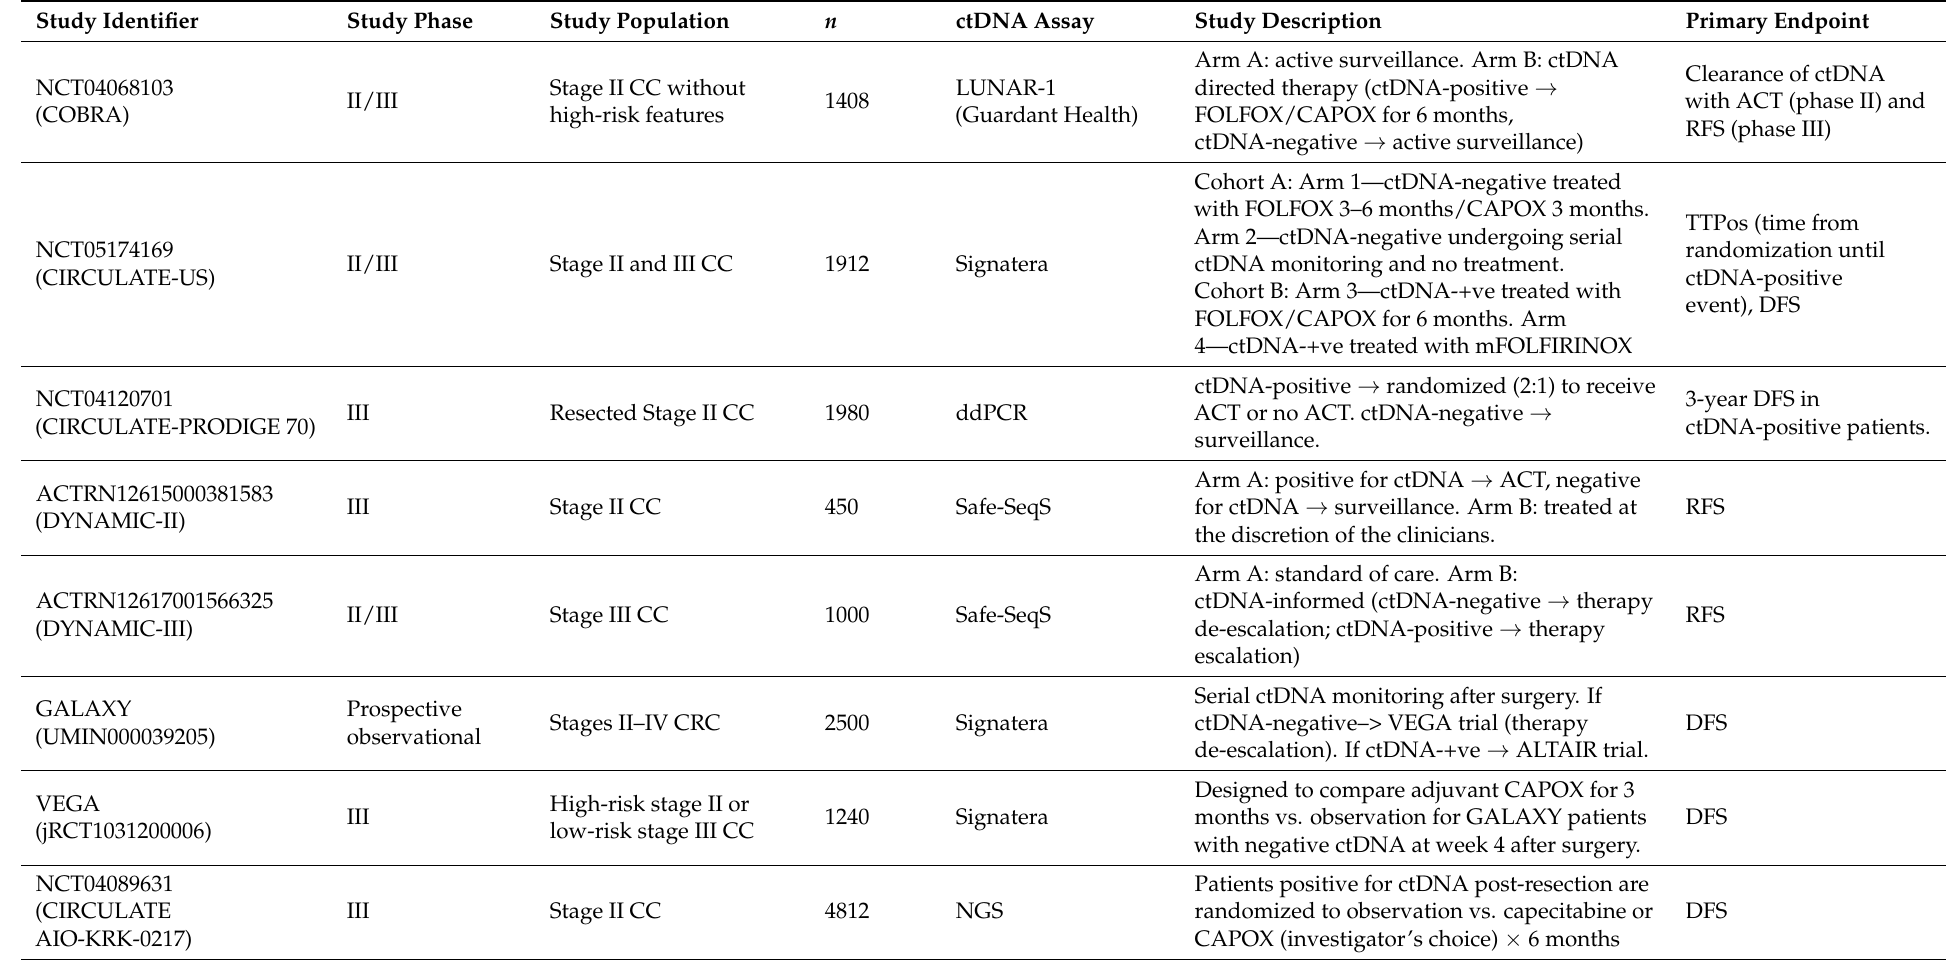
Table 3. Selected clinical trials investigating the ctDNA-guided treatment strategies in patients with colorectal cancer